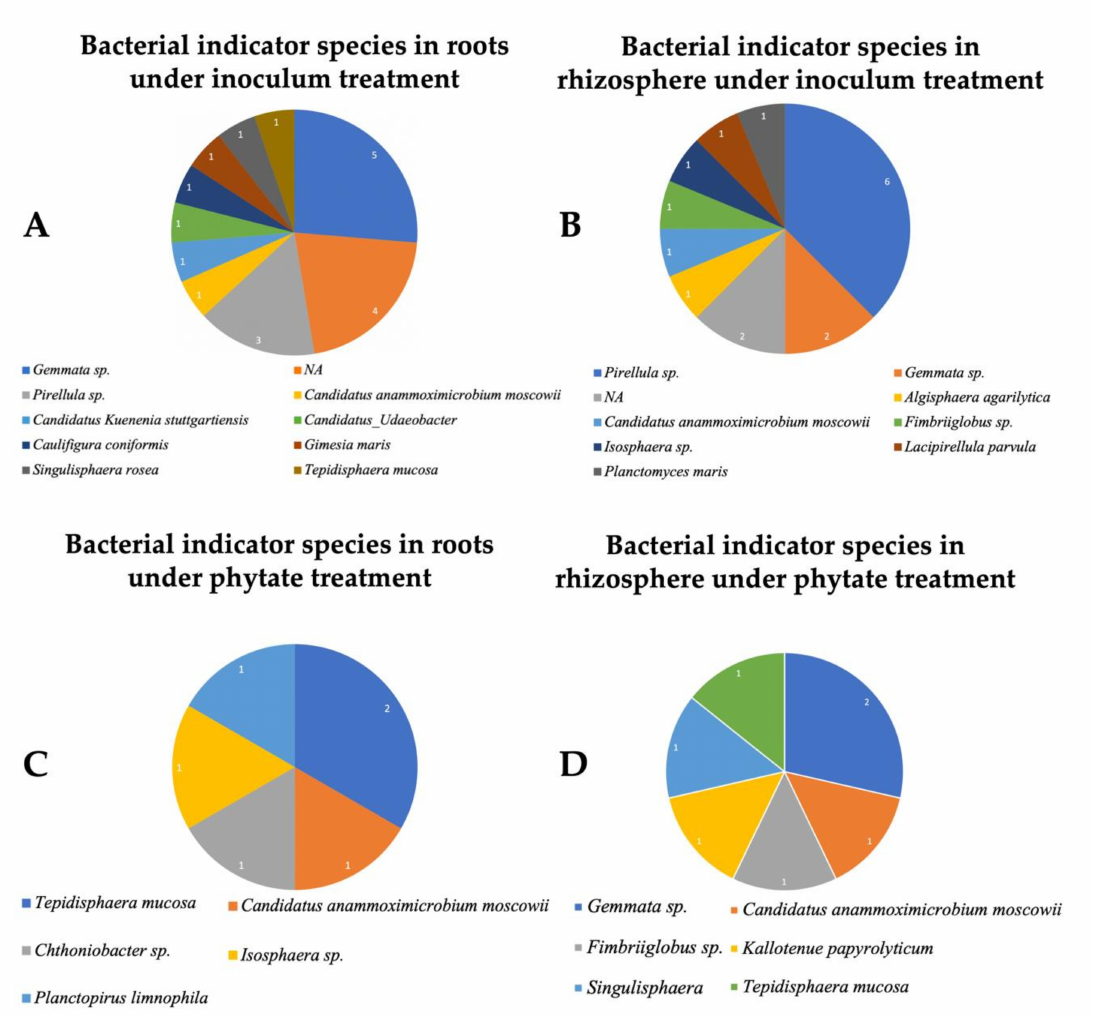
Figure 3. Bacterial indicator species of soybean microbiome at the genus level. The most representative species of the soybean microbiome were identified through indicator species analysis. Bacterial indicator species under inoculum treatment in root ( A ) and in rhizosphere ( B ) biotopes; and under phytate treatment in root ( C ) and in rhizosphere ( D